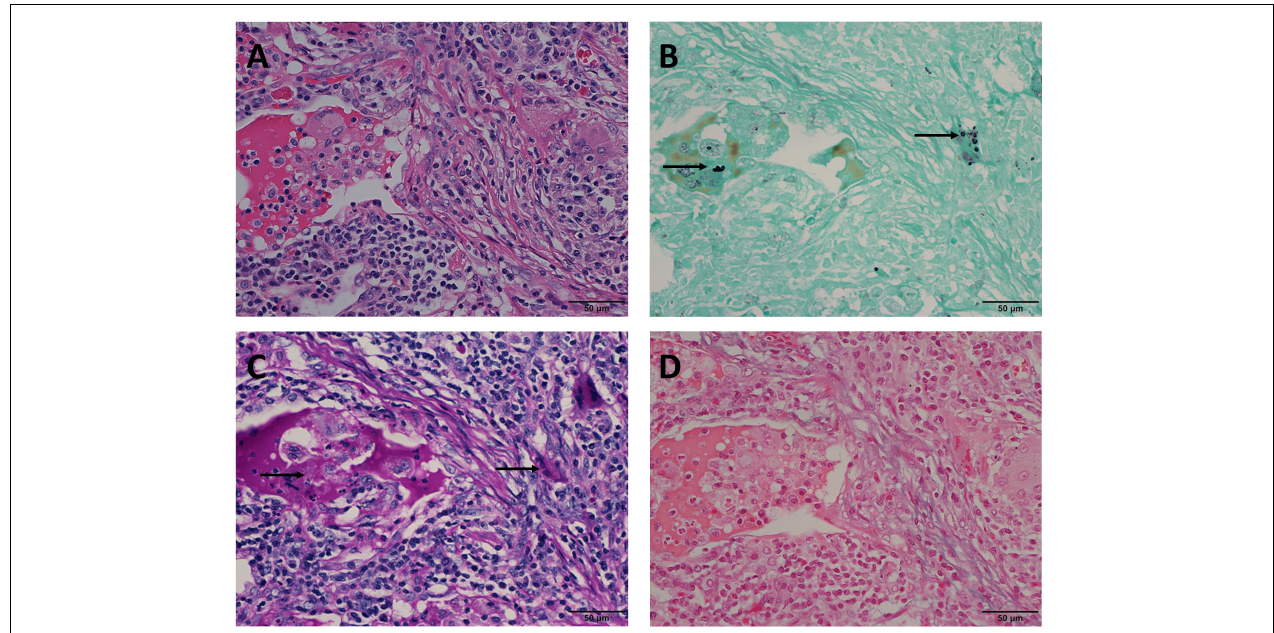
FIGURE 4 | Mode D: GMS(+), PAS(–), AB(–) in the same view of lung tissues with pulmonary cryptococcosis (male, aged 61 years, solitary nodule, maximum diameter of 1.2 cm). (A) H&E staining shows circular structures resembling Cryptococcus spores. (B) GMS(+) reveals Cryptococcus spores (arrows) that are observable by their brown-black color. (C) PAS(–) does not reveal Cryptococcus magenta, but suspicious magenta round-like structures are covered with non-specific staining (arrows). (D) AB(–) does not reveal Cryptococcus blue. GMS, Grocott methenamine silver; PAS, periodic acid-Schiff; AB, Alcian blue; H&E, hematoxylin and eosin. (Original magnifications: A–D , × 400).